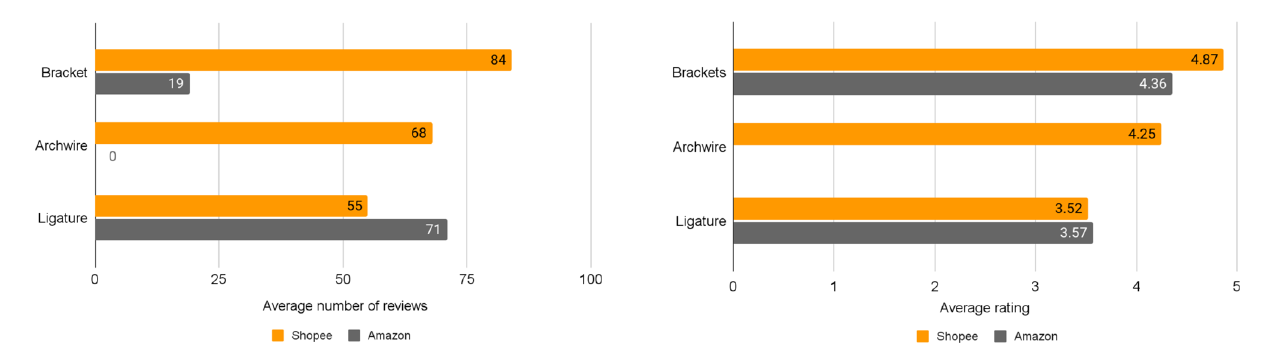
Figure 3. Average star rating of orthodontic products on Amazon and Shopee, using a 5-star rating system.